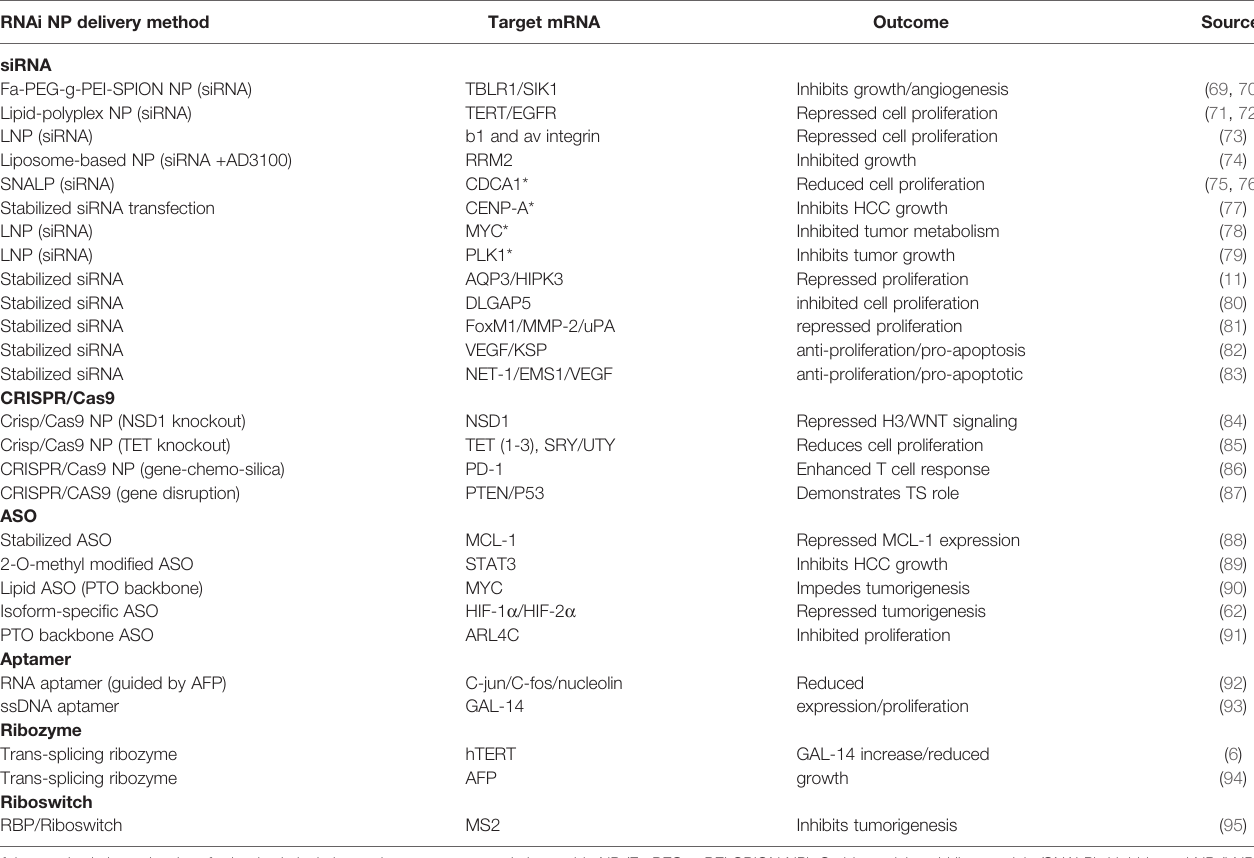
TABLE 2 | RNAi anti-proliferation therapeutics. RNAi NP delivery